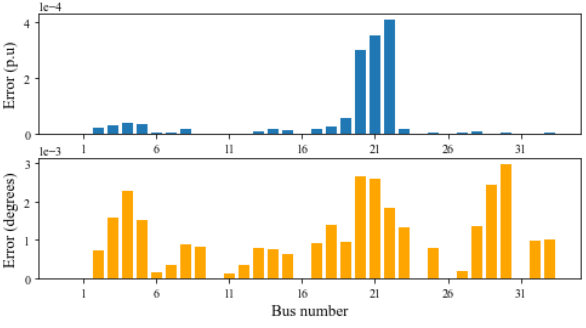
Figure 14. State estimation error (OP): 33-bus system, N m =